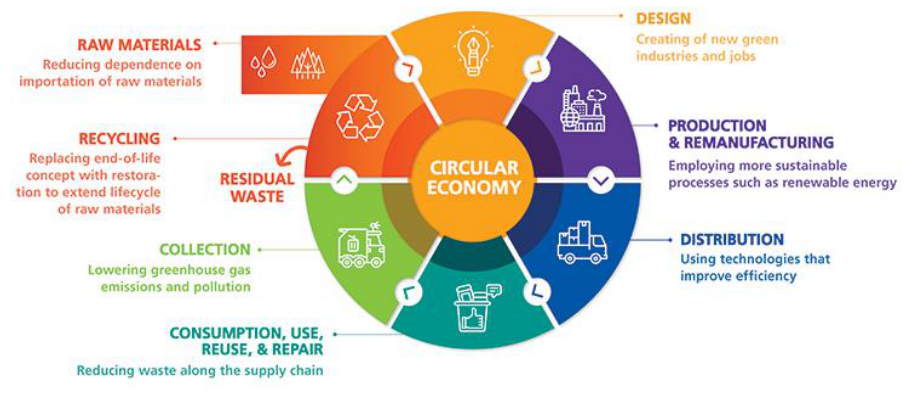
Figure 3 . Circular economy model [28] . Figure 3. Circular economy model